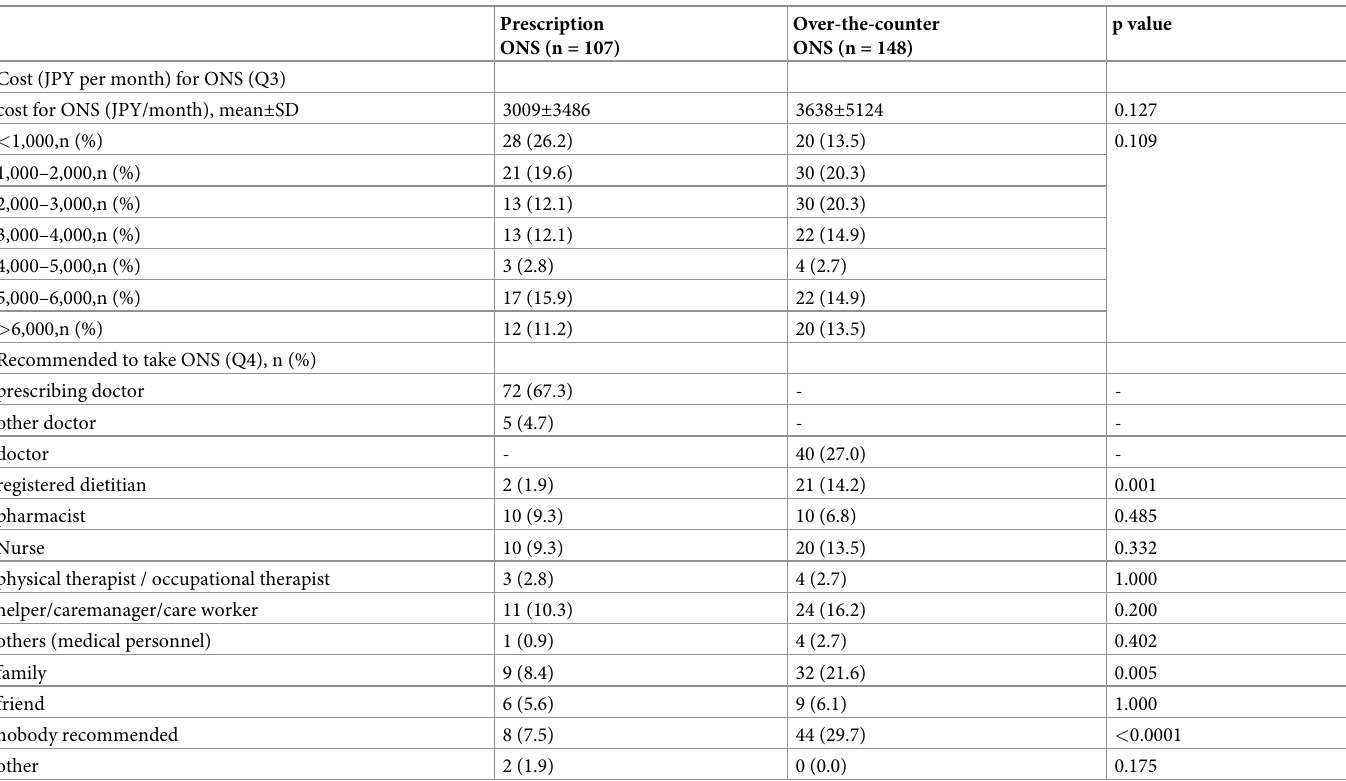
Table 6. The result of the survey questions